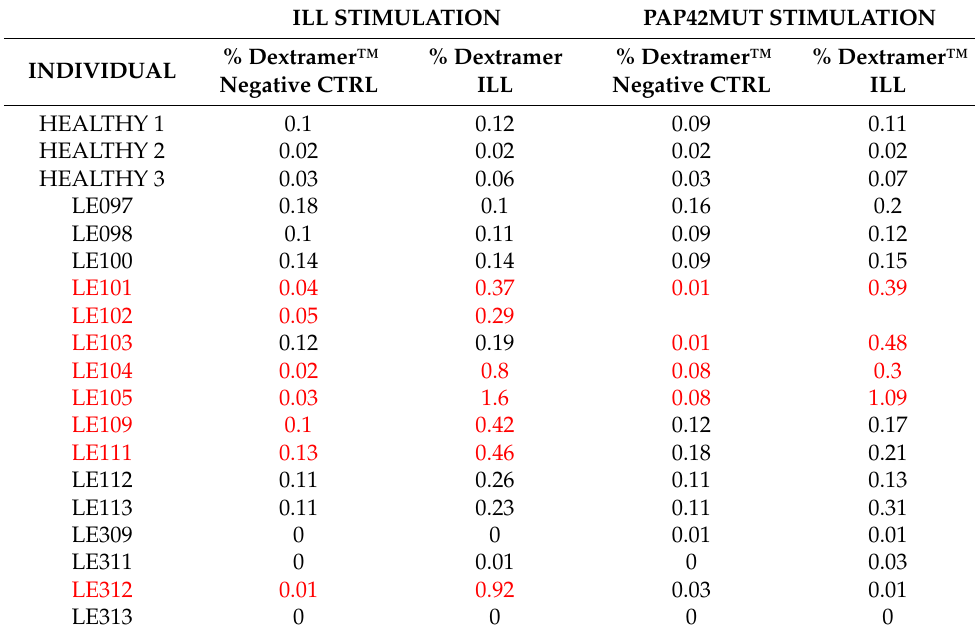
Table A4. Positive cells for Dextramer™ negative control and Dextramer™ ILL (red = patients exhibiting ILL-specific